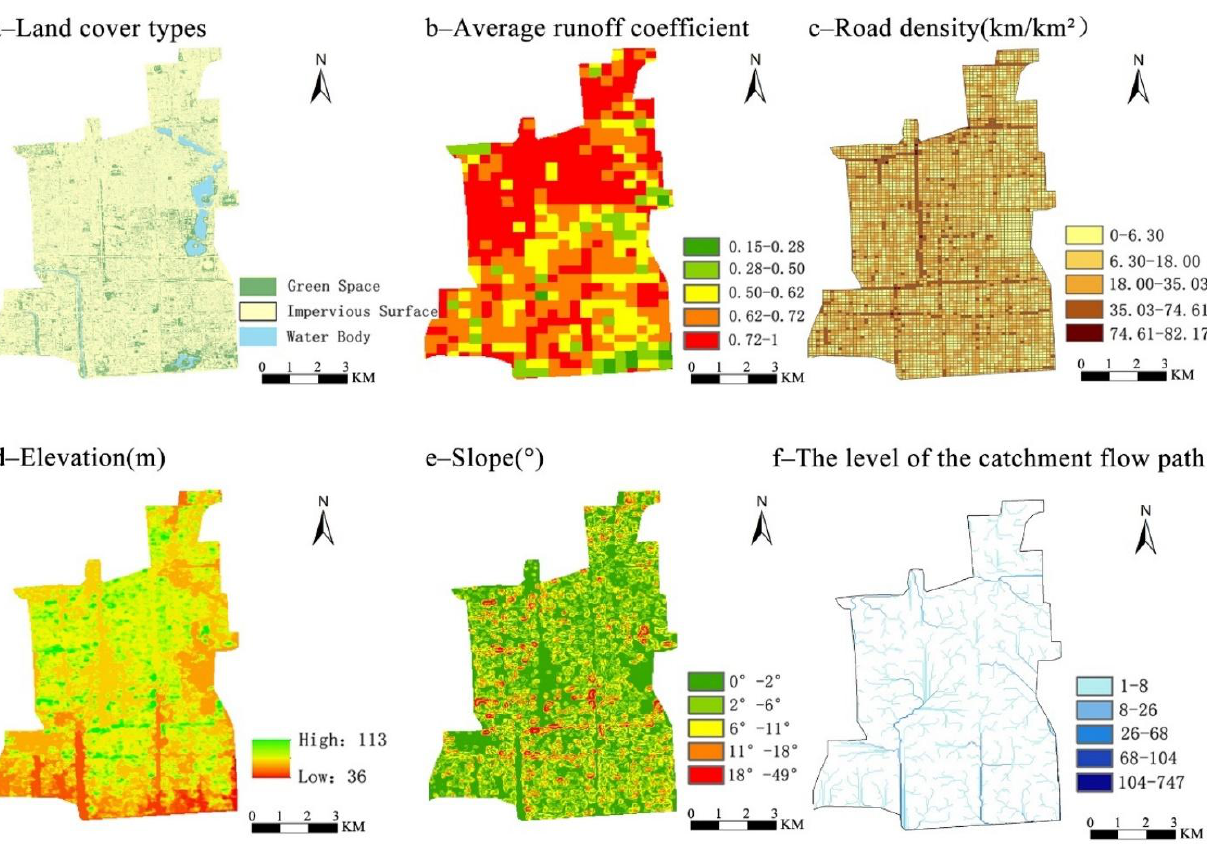
Figure 7. Calculation results of six influencing indicators of location decision. ( a ) Land cover types distribution of Xicheng, ( b ) average runoff coefficient distribution of Xicheng, ( c ) road density distribution of Xicheng, ( d ) elevation distribution of Xicheng, ( e ) slope distribution of Xicheng, ( f ) the level of the catchment flow path distribution of Xicheng.